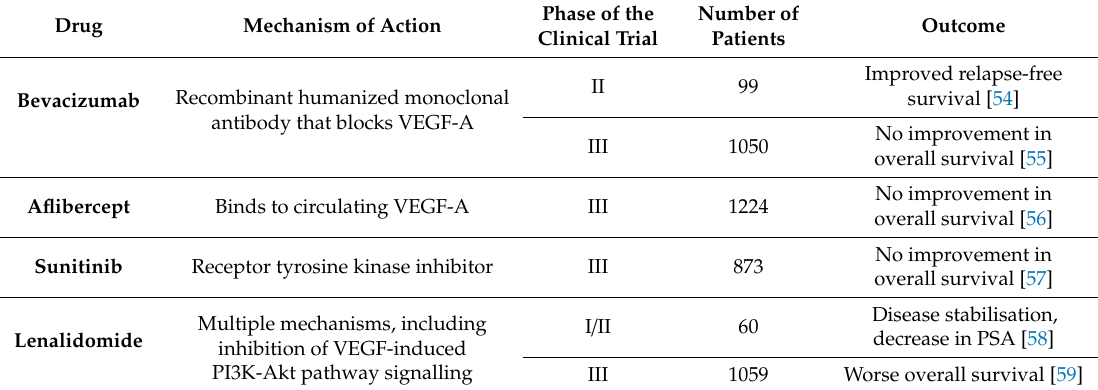
Table 2. Anti-angiogenesis clinical studies in treatment of prostate